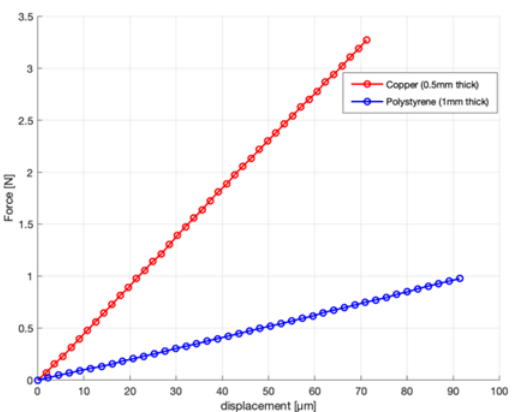
Figure 3. Force–displacement curve of a copper 0.5 mm sample, polystyrene 1.5 mm sample, and polystyrene 1.5 mm sample, obtained in the three-point bending test.